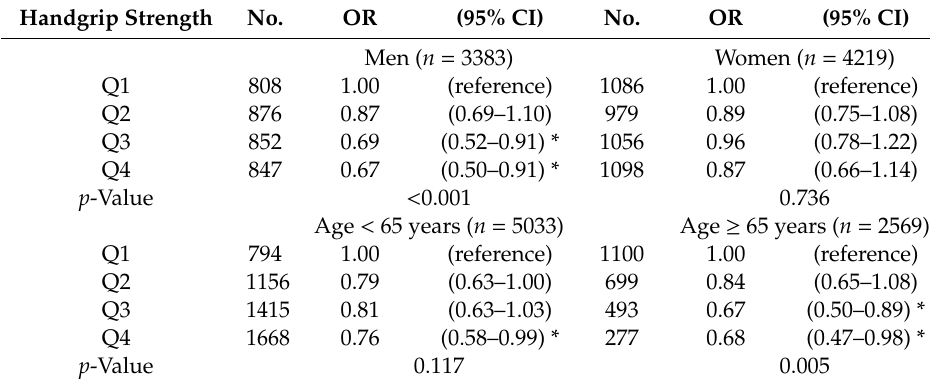
Table 4. OR (95% CIs) for adverse cardiometabolic health by category of handgrip strength by sex and age